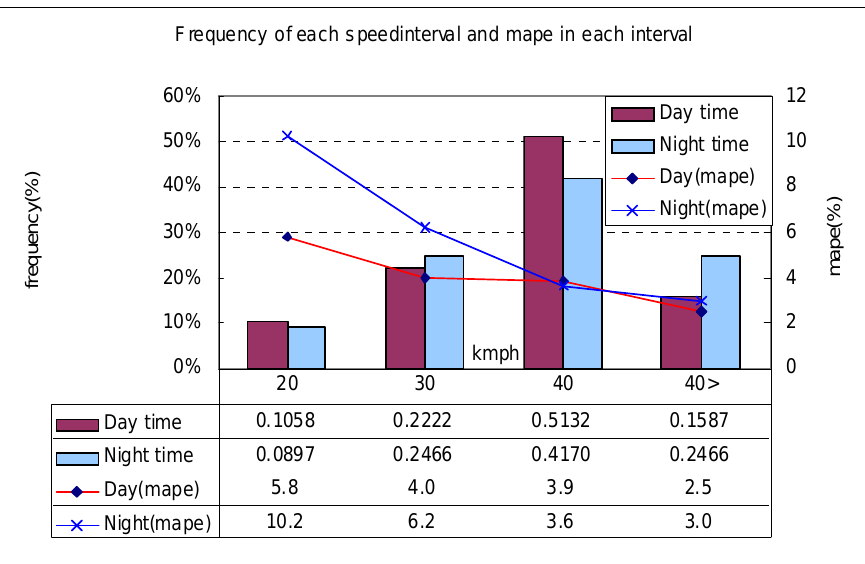
Figure 12. Speed distribution and MAPE for each speed